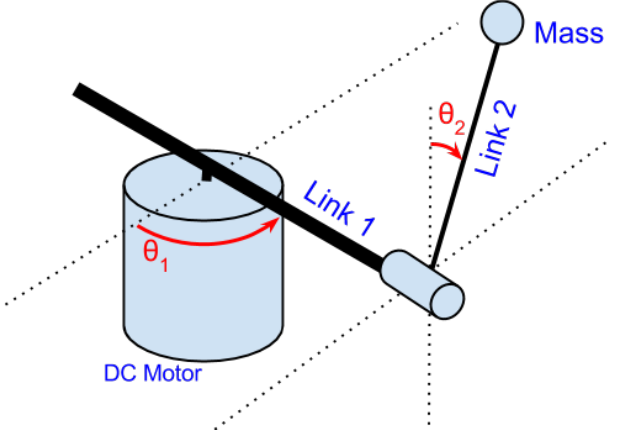
Figure 4. Complete Furuta Pendulum Motor Kit.